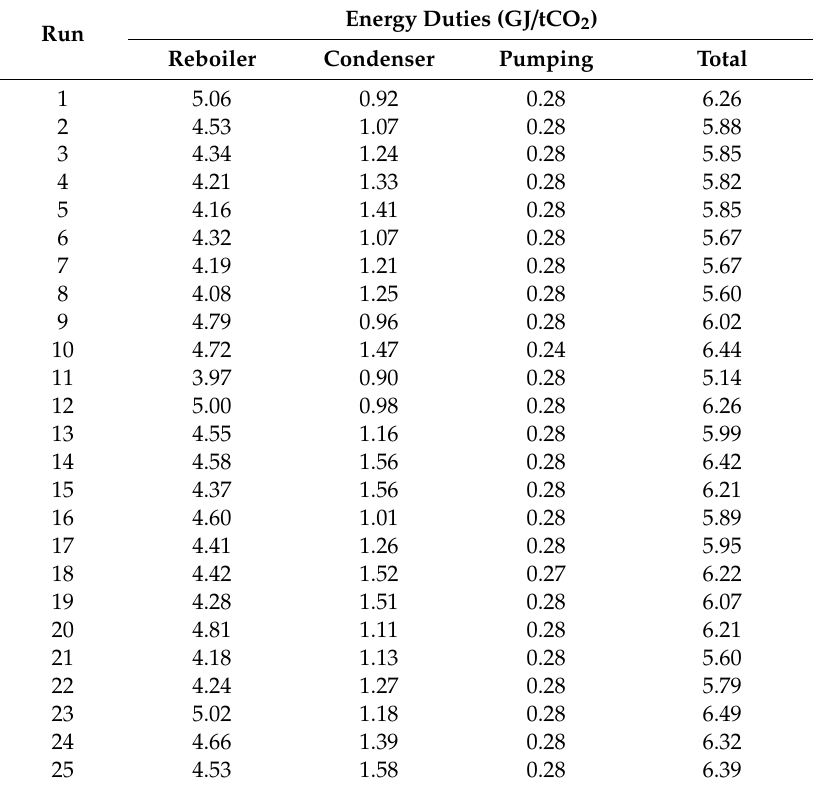
Table 4. Energy duty per tonne of captured CO 2 for each individual unit of the capture plant. Energy Duties (GJ / tCO 2 Run